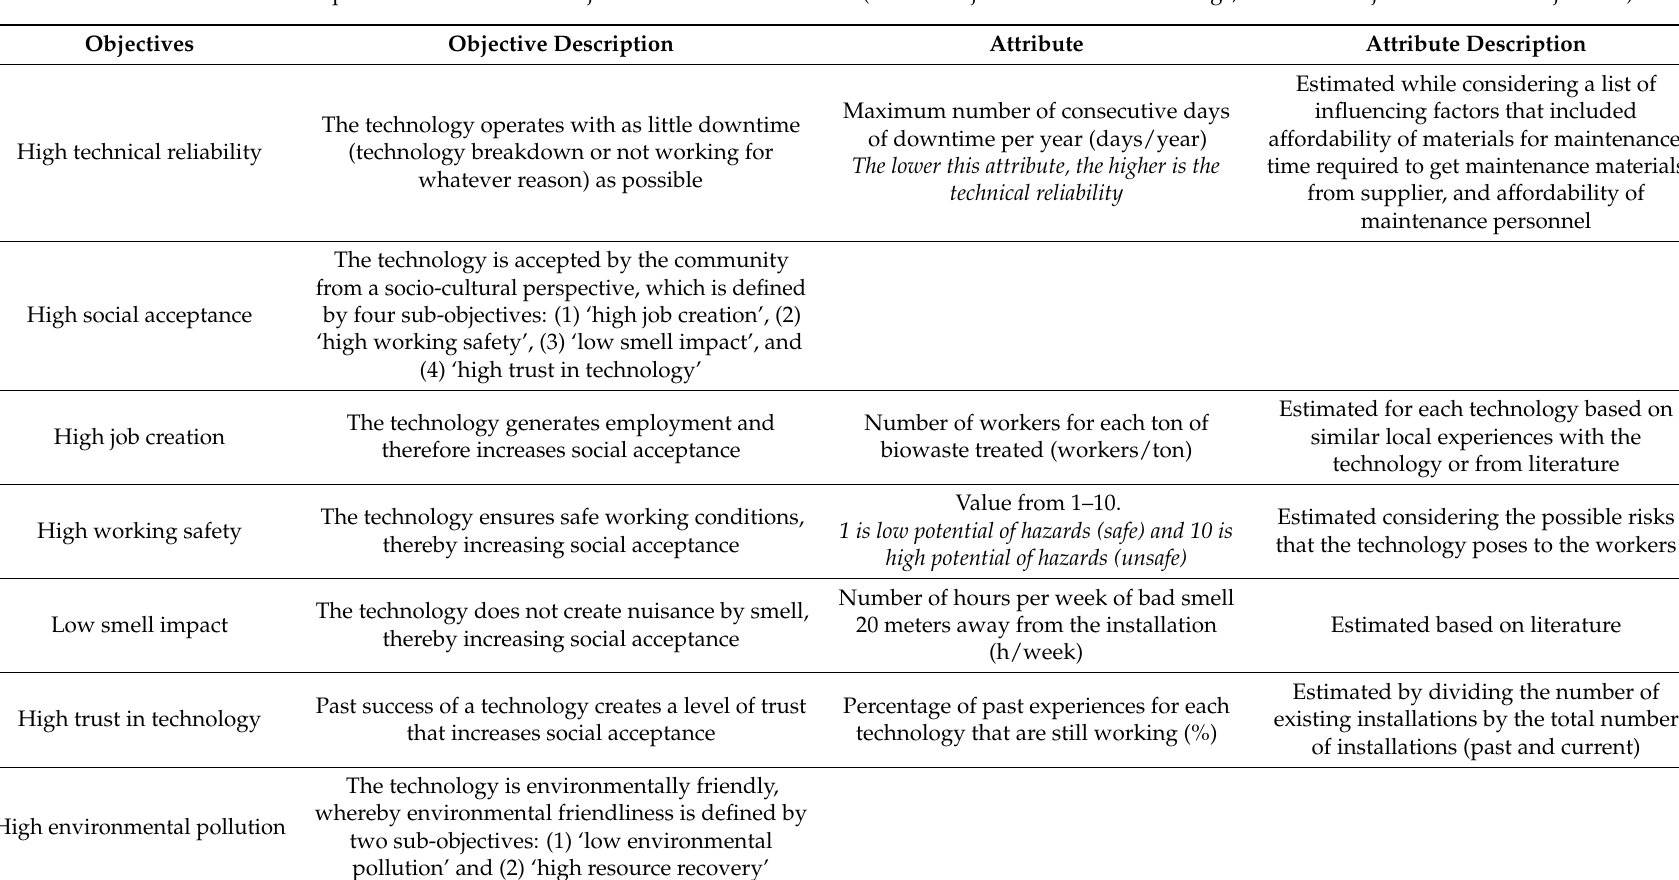
Table 1. Definition and description of the evaluation objectives and their attributes (shaded objectives are main headings; unshaded objectives are